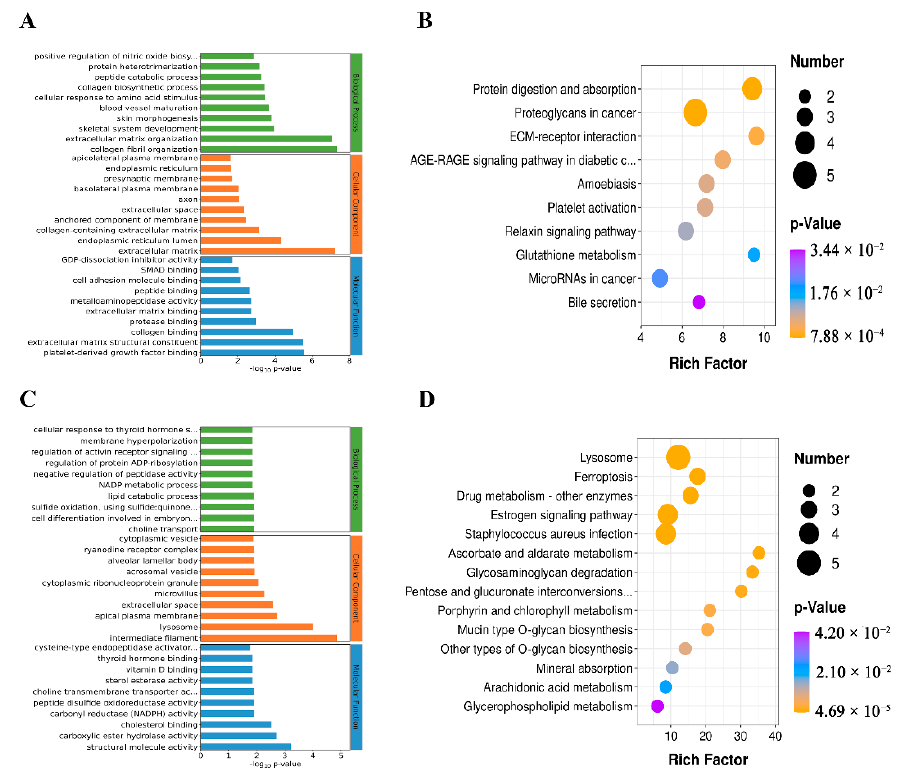
Figure 8. Analysis of GO and KEGG genes with the same expression trend. ( A , B ) present the GO and KEGG enrichment of co-up-regulated genes. ( C , D ) present GO and KEGG enrichment analyses with downregulated expression of proteins and mRNA.